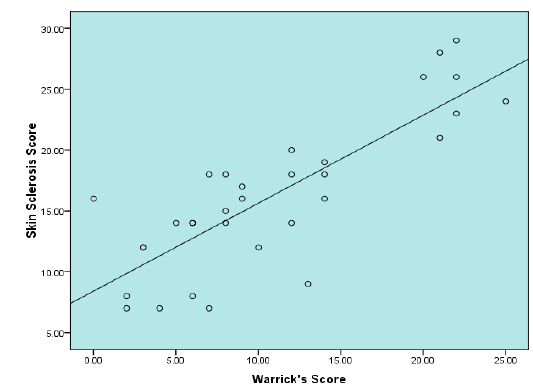
Figure 2. The correlation of Warrick’s scores and EDD index in scleroderma lung patients (r=0.72, P=0.001)